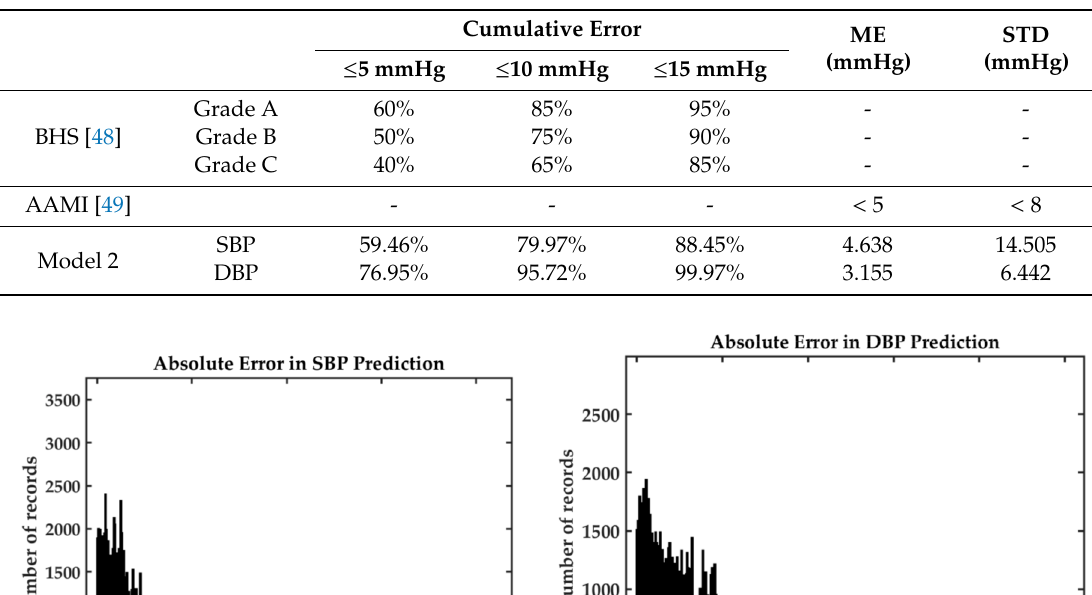
Table 4. Performance evaluation based on BP estimation standards on 135,641 records.